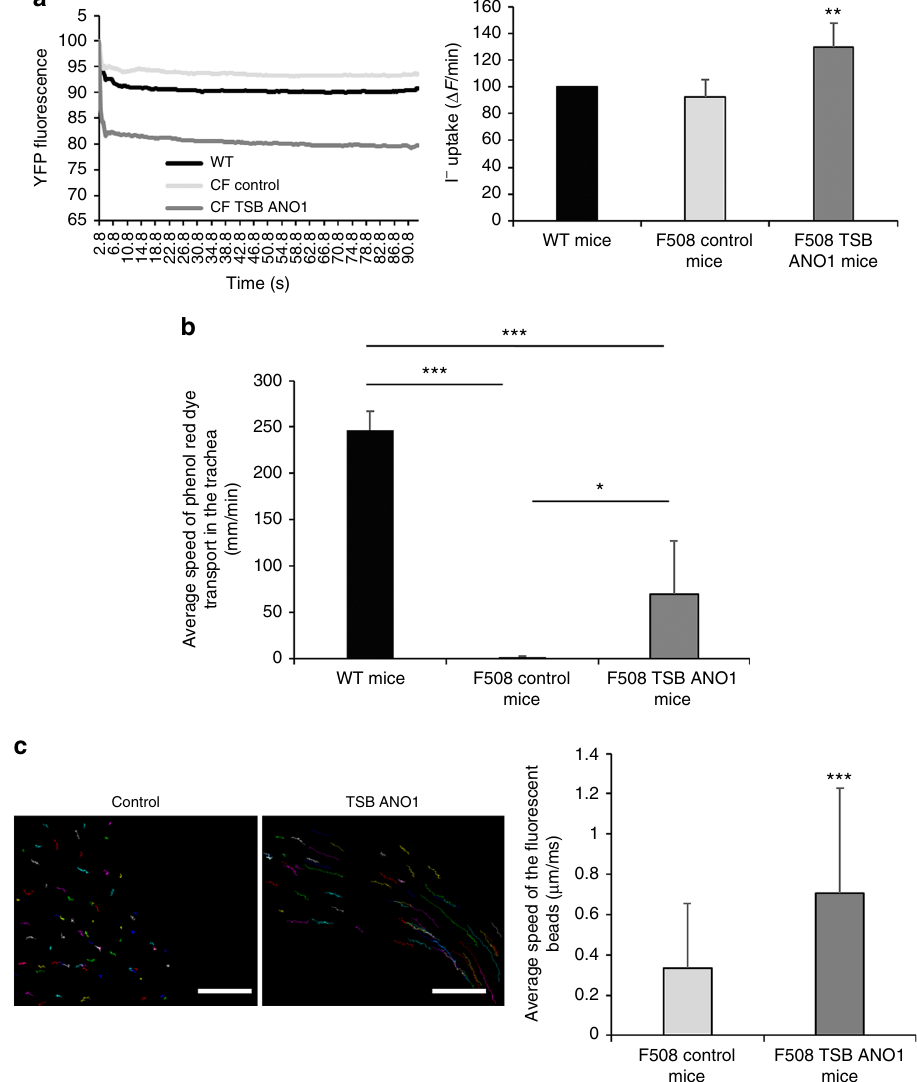
Fig. 7 miR-9-speci fi c TSB increases ANO1 activity and mucus dynamics in CF mice. For all the experiments, we used 8-week-old male 129-C ftr t m1Eur CF model mice homozygous for the F508del mutation in the 129/FVB outbred background (F508del-CFTR) and their wild-type littermates obtained from CDTA-CNRS (Orléans, France). a Representative and original traces of ANO1 channel activity ( left ) and quanti fi cation ( right ) of cells isolated from wild- type mice ( n = 8), CF mice instilled with ANO1 TSB ( n = 7) or a negative control ( n = 7). Histograms represent the average values ± SDs and were compared using one-ANOVA test coupled with Dunnett ’ s, Bonferroni ’ s, and Tukey ’ s post hoc test. b Effect of TSB control or TSB ANO1 on the transport of phenol red dye in the trachea. Histograms represent the average values ± SDs and were compared using one-way ANOVA test coupled with Dunnett ’ s, Bonferroni ’ s, and Tukey ’ s post hoc test. c Effect of TSB control or ANO1 TSB on mucus dynamics on the trachea of CF mice. The movements of 100 beads were quanti fi ed for each condition, and the average speed ( µ m/ms) was determined. Scale bar 40 µ m. Histograms represent the mean values ± SDs and were compared using Student ’ s t